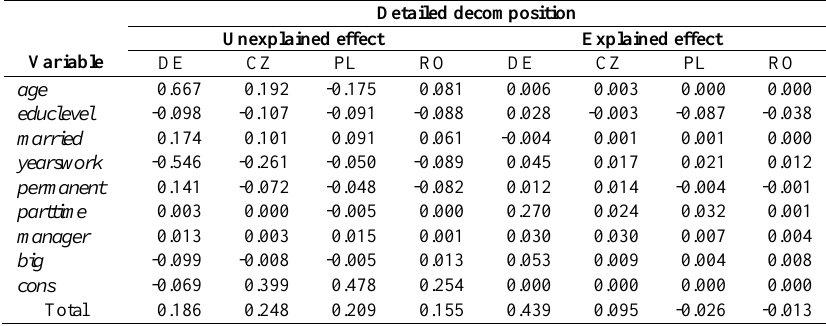
Table 3. The results of the detailed Oaxaca-Blinder decomposition